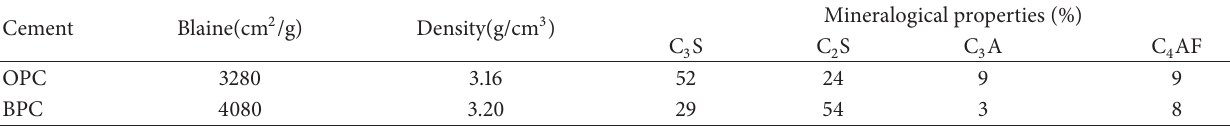
Table 1: Bogue composition of cement used in concretes.